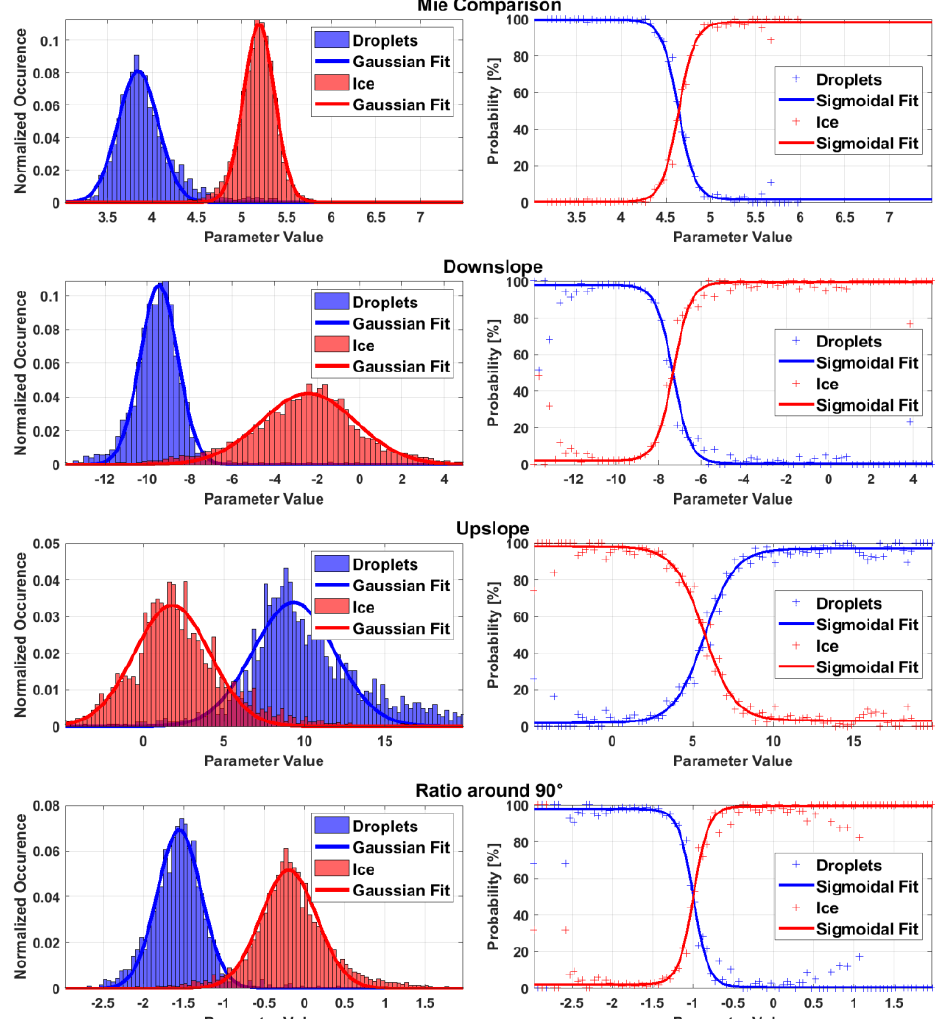
Figure 6. Left: normalized histograms of the discrimination features, f 1 , f 2 , f 3 and f 4 , of all manually classified particles (blue: droplets, red: ice) from the ACLOUD campaign that were used for the calibration of the discrimination algorithm. The histograms can be nicely fitted by normal distributions (solid lines). Right: corresponding probability for a given particle with a given feature parameter value to be classified as ice or a droplet, including sigmoidal